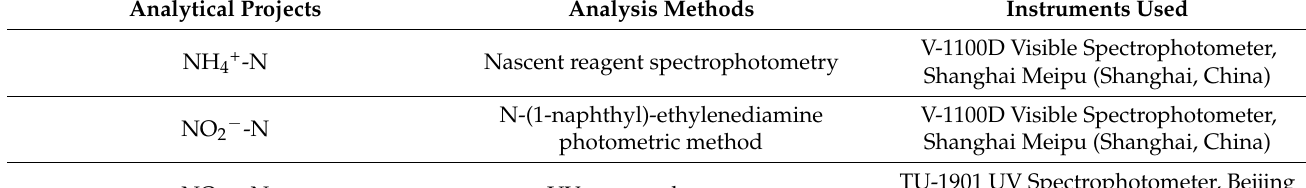
Table 1. Analysis methods and equipment used for key